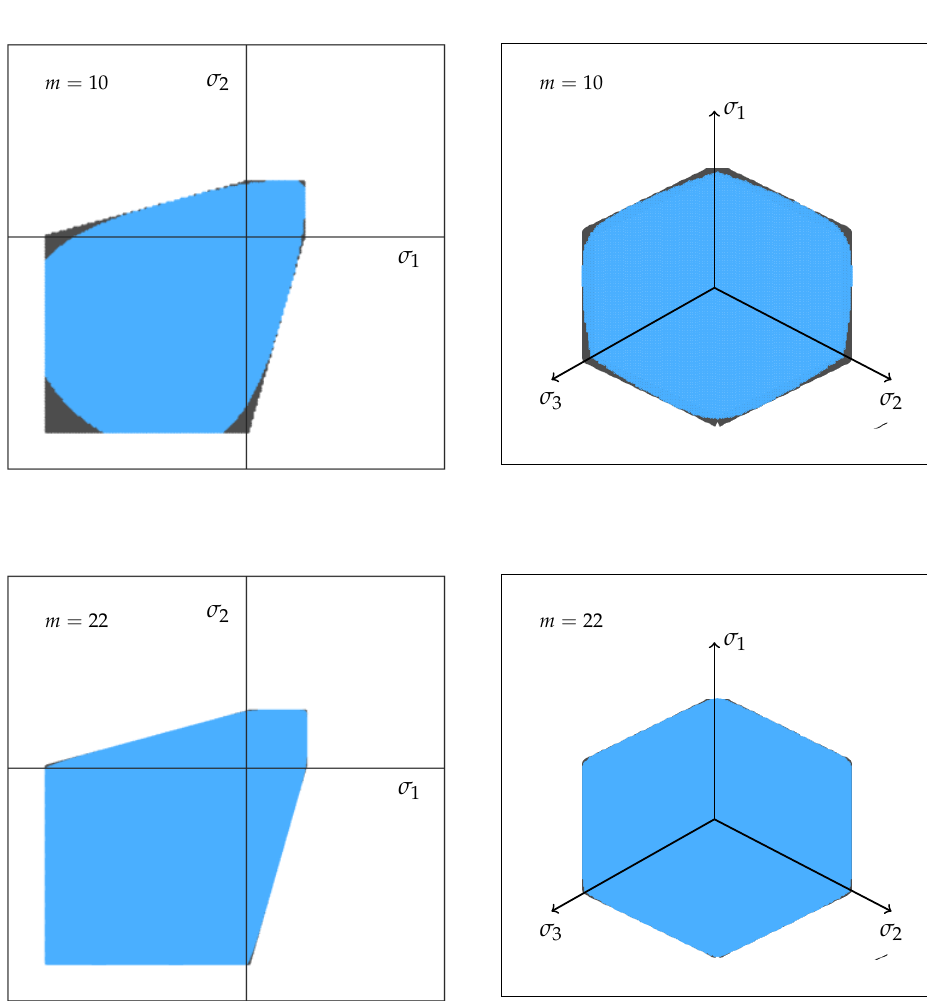
Figure 13. Comparison of the failure surfaces for the theoretical Mohr-Coulomb criterion without scatter (black) and a Mohr-Coulomb criterion adapted with Weakest-Link-Theory (blue). Weibull shape parameters are m = 10 and m =